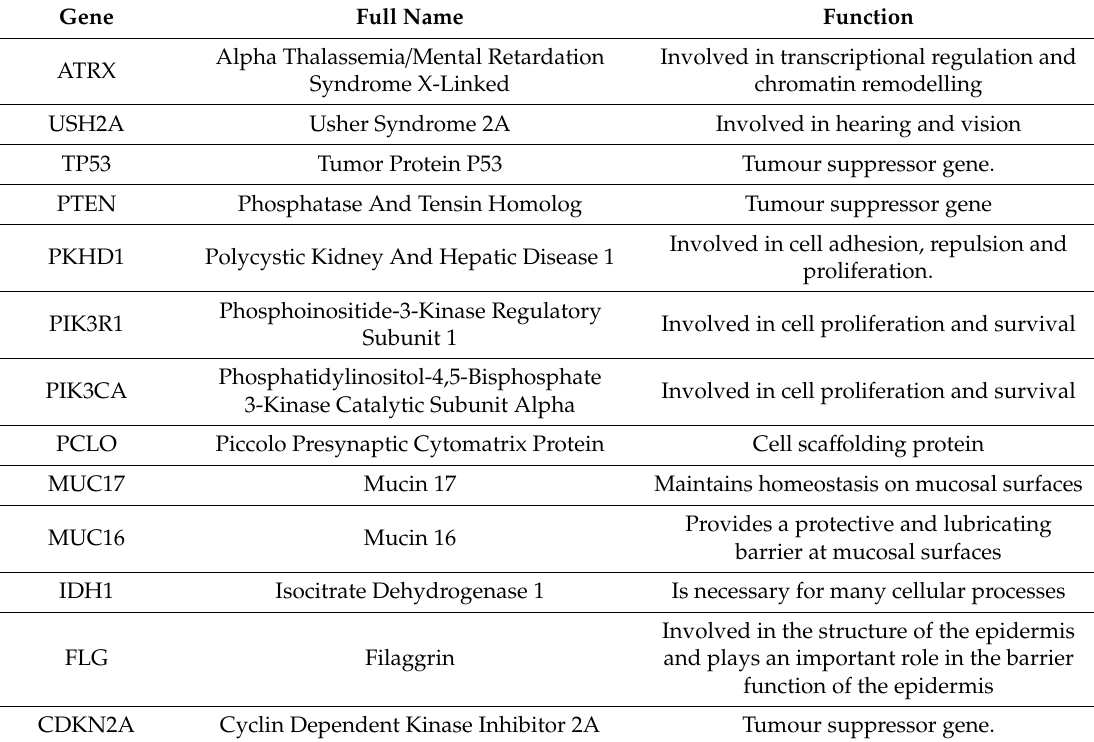
Table 2. Full name and function of the 13 genes associated with GBM treatment